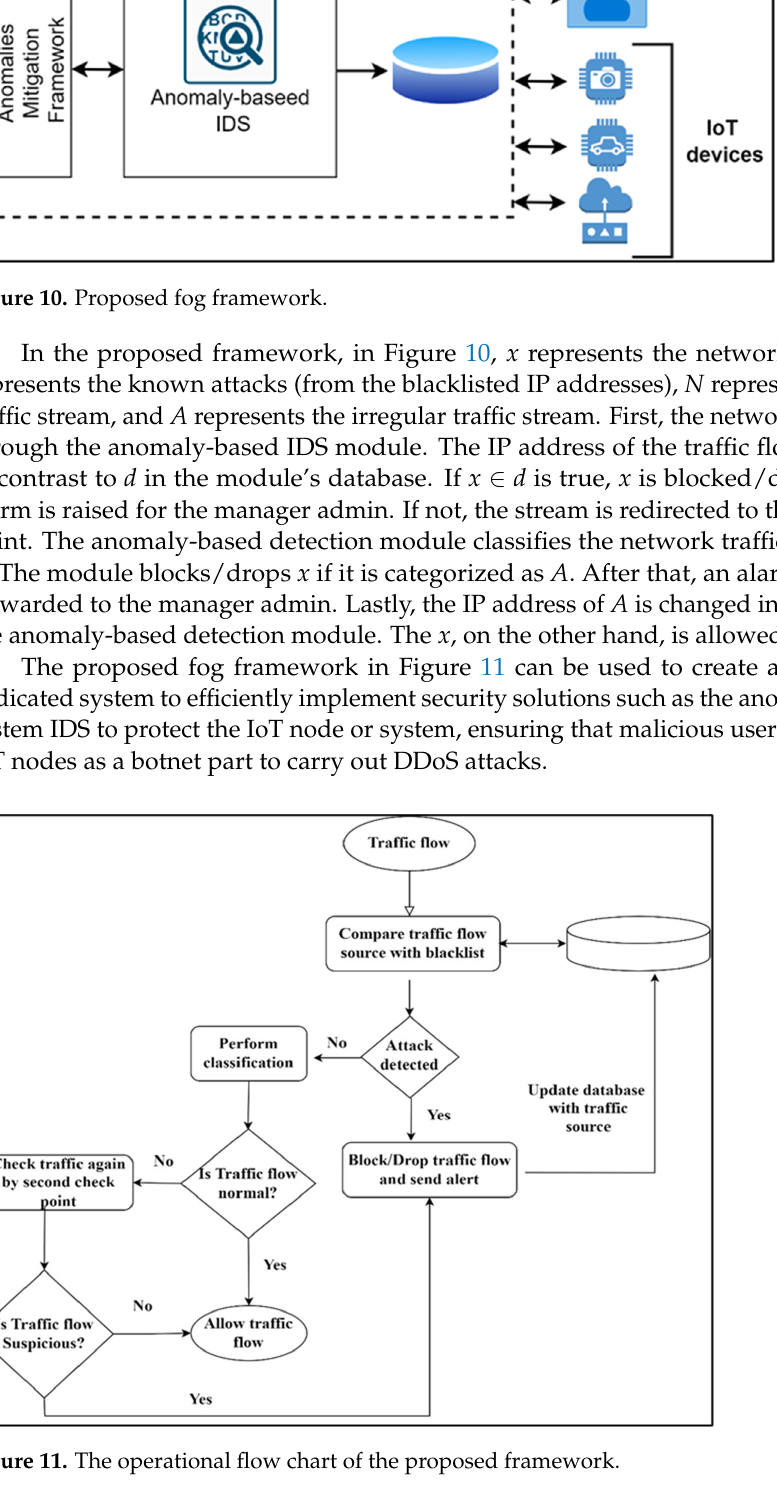
Algorithm 2: Proposed Anomaly Mitigation Algorithm